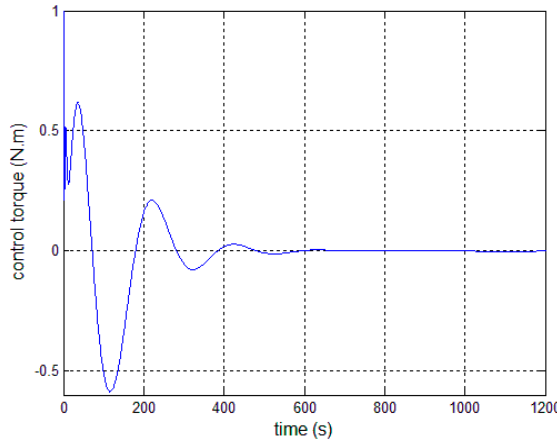
Figure 9. Antenna pitch angular velocity error—controller, Equation (23).